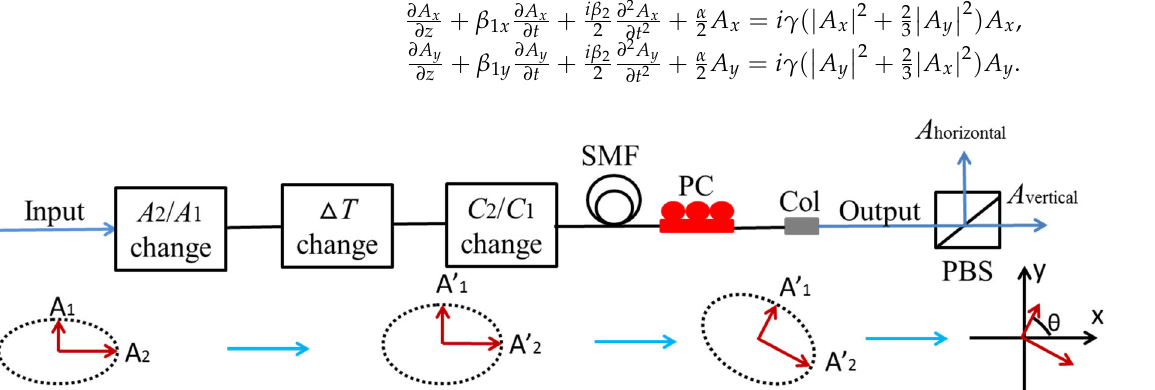
Figure 1. Optical fiber system model in our simulation.